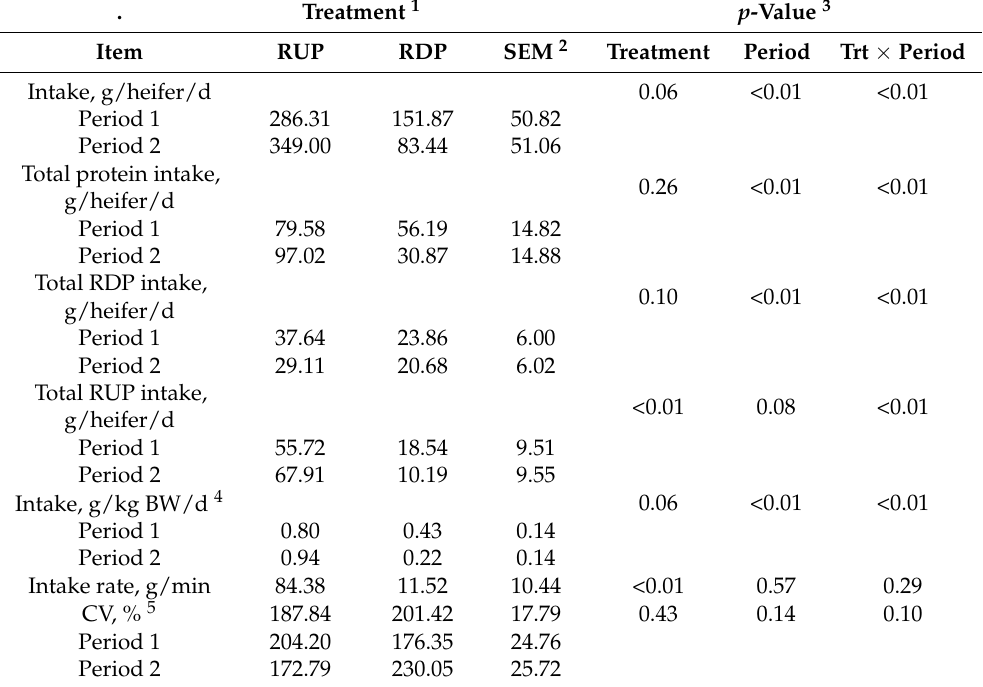
Table 4. Intake, intake rate, and % coefficient of variation (CV) data of yearling heifers supplemented with rumen undegradable or degradable protein while grazing improved dryland pastures.